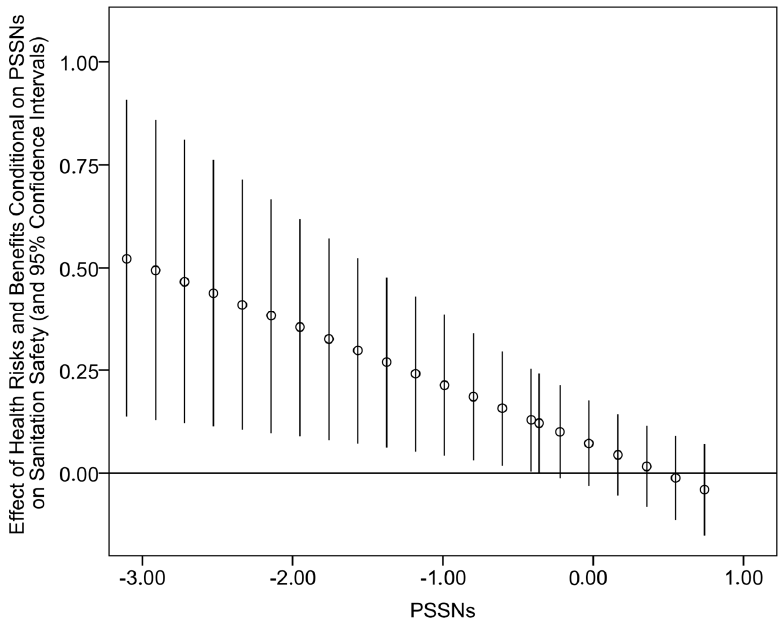
Figure 4. Effects of perceived health-related risks and benefits on sanitation safety conditional on different values of PSSNs (small circles) and their 95% confidence intervals.